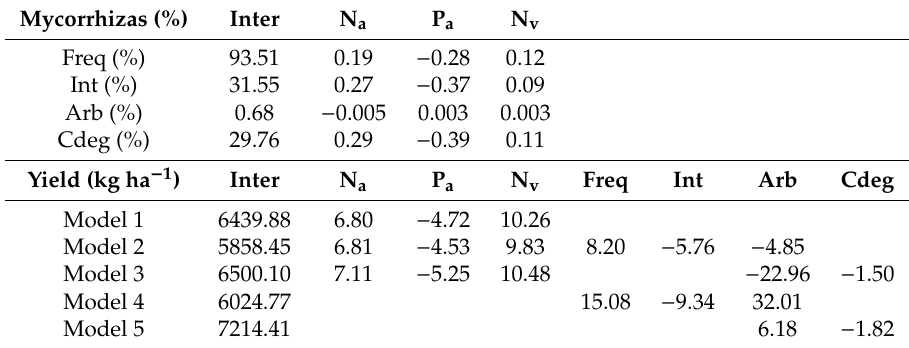
Table 4. Forecasting potential of fertilizers over arbuscular mycorrhiza parameters and crop yield in winter